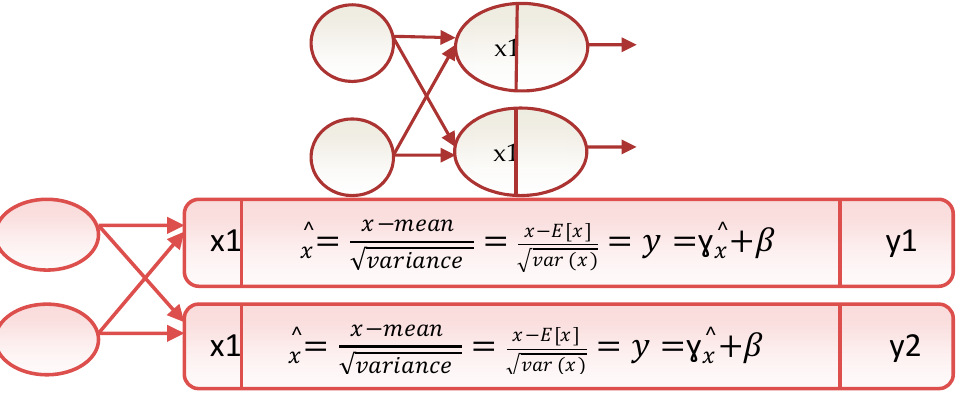
Figure 7. Batch normalization with mean and variance.